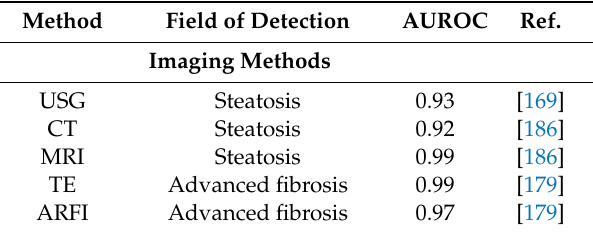
Table 4. Values of area under the receiver-operating characteristics curve (AUROC) for the most accurate imaging